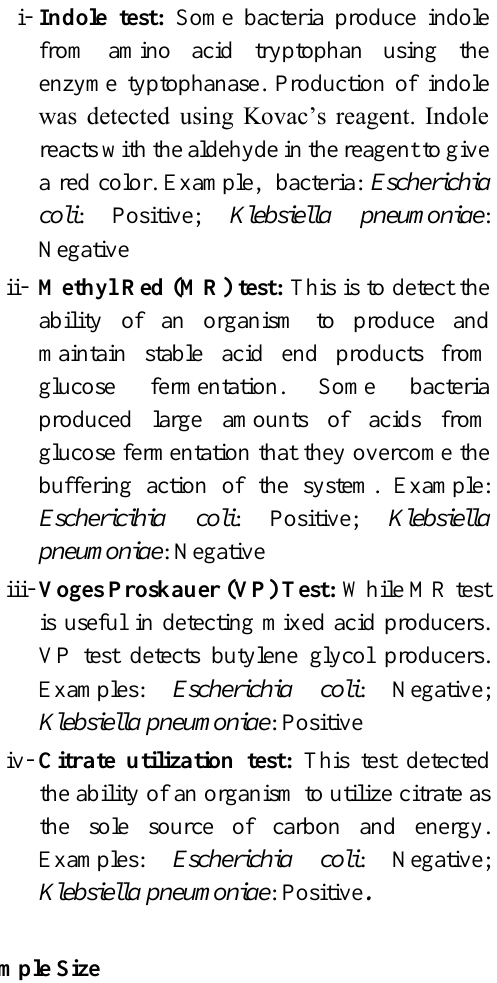
four reactions are: Indole test, Methyl Red test, Voges Proskauer test and Citrate utilization test. The letter “i” is only for rhyming